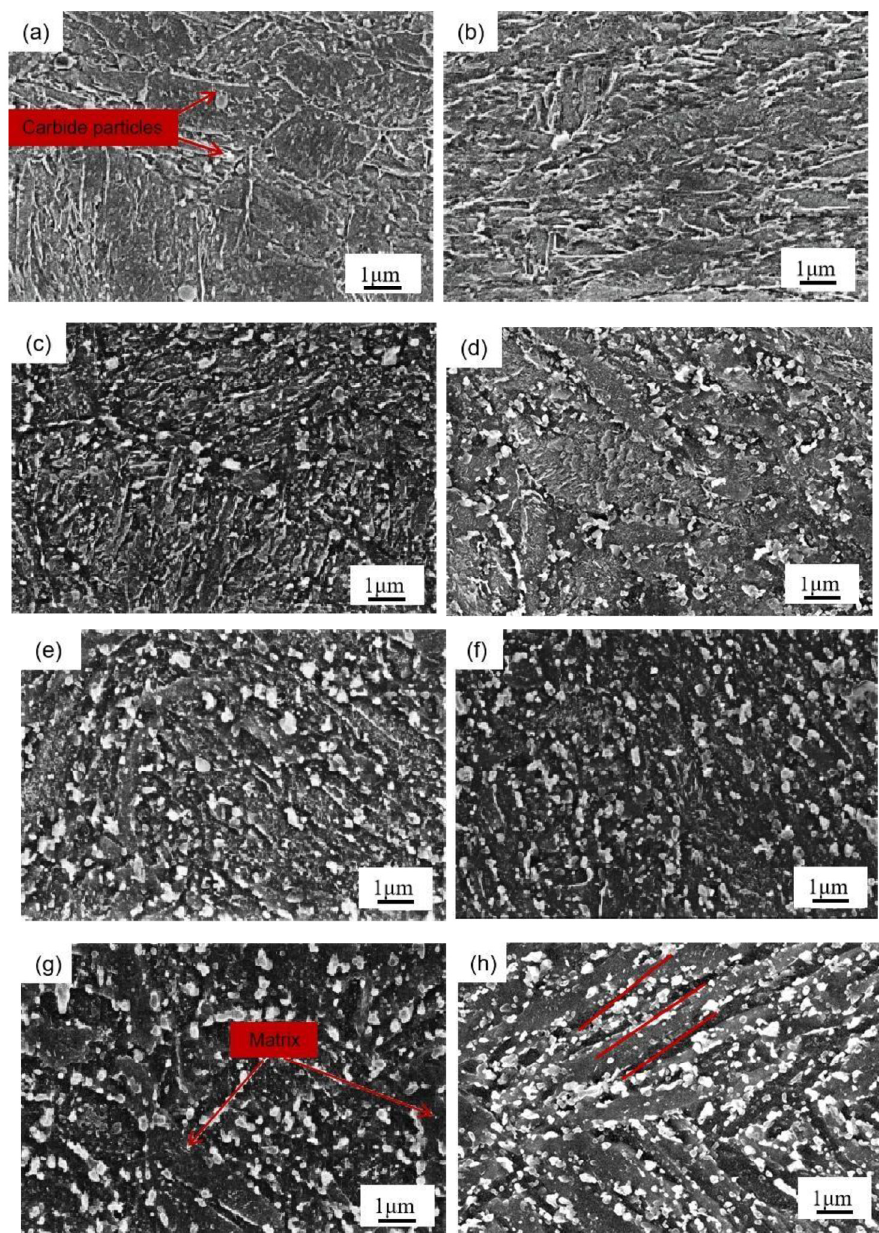
Figure 4. SEM micrographs of tested steels at 650 ◦ C after different holding times: ( a ) 0.3 Si—0 h, ( c ) 0.3 Si—4 h, ( e ) 0.3 Si—16 h, ( g ) 0.3 Si—64 h, ( b ) 1.0 Si—0 h, ( d ) 1.0 Si—4 h, ( f ) 1.0 Si—16 h, ( h ) 1.0 Si—64 h.